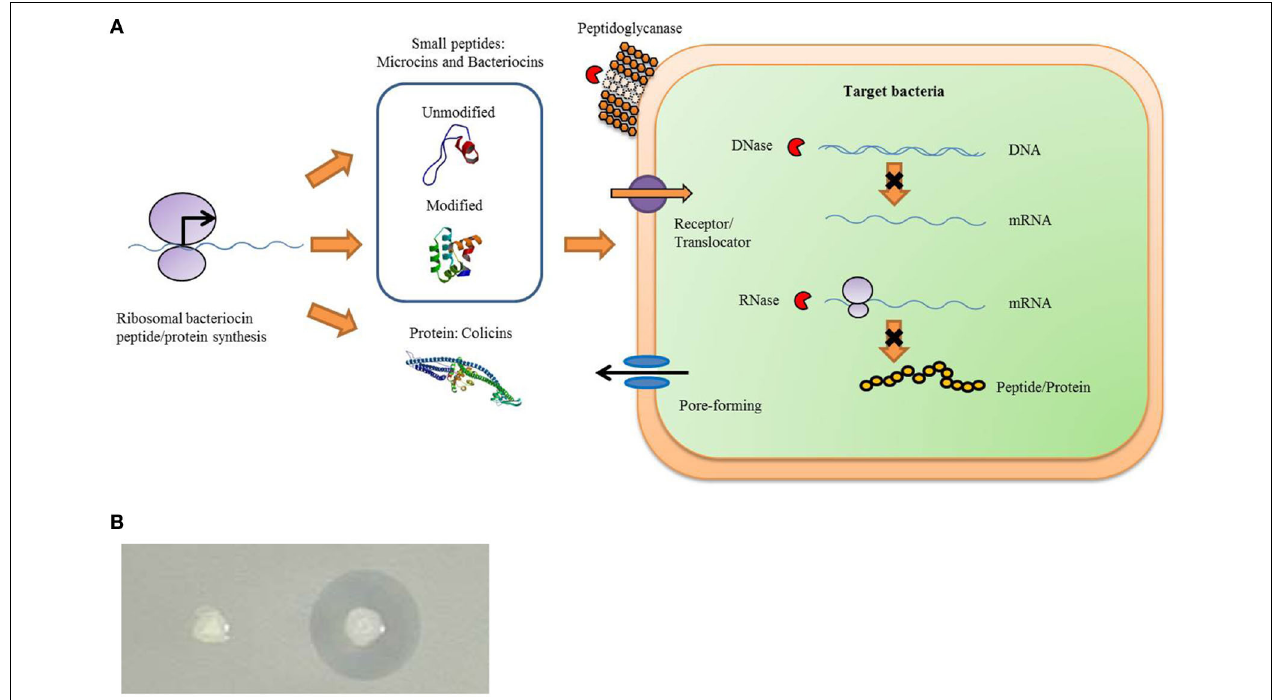
FIGURE 1 | Bacteriocins function as a natural bacterial immune weapon system. Gram-positive and Gram-negative can produce many kinds of bacteriocins that allow bacteriocin-producing bacteria to have the ability to inhibit the growth of sensitive bacteria. (A) General process of bacteriocins production and antibacterial functions. Bacteriocins are proteins or peptides synthesized by the ribosomal. When released by bacteriocin-producing bacteria, it can become combined with the corresponding receptor on the surface of the sensitive bacteria to kill the bacteria. The sensitive bactericidal mechanisms include the pore-forming type, a nuclease type with DNase and